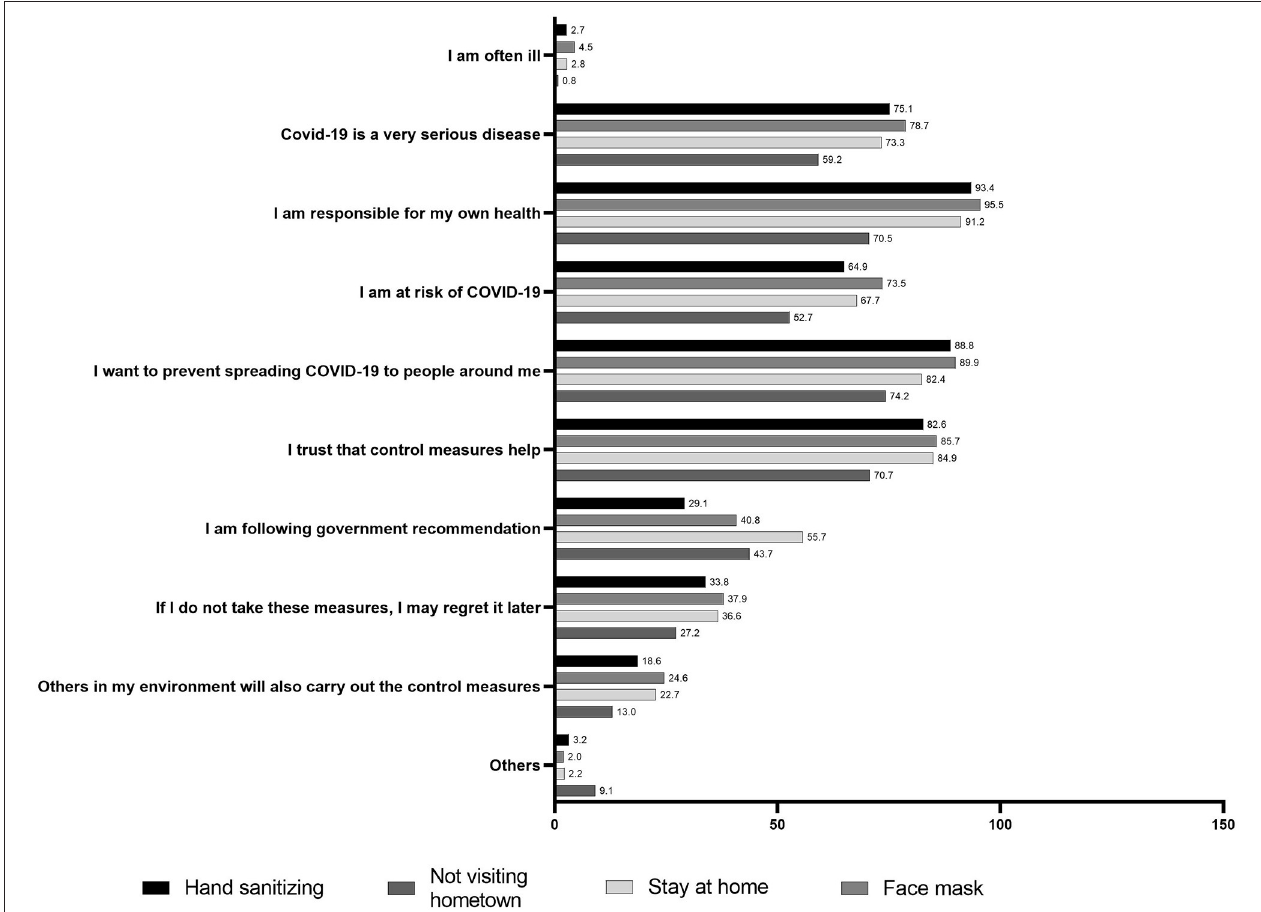
FIGURE 4 | Motivating factors that drive the willingness to carry out preventive measures of COVID-19 in Indonesia ( n =